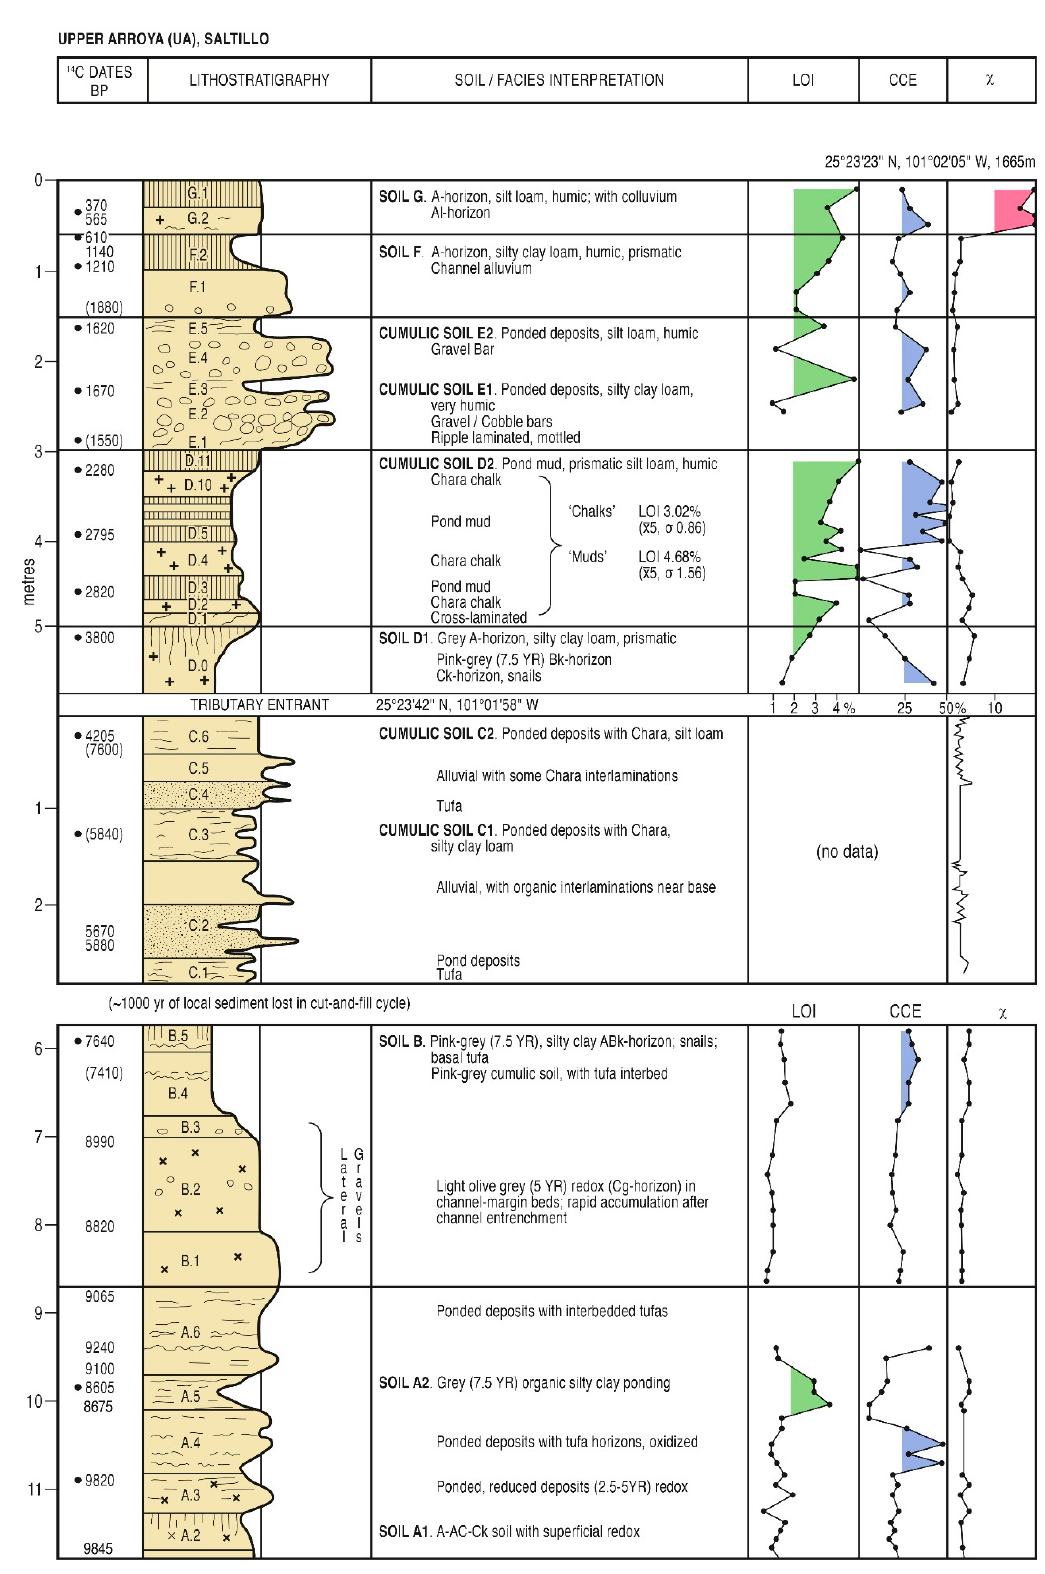
Figure 5. Upper Arroyo (UA) sedimentology with loss-on-ignition, carbonate, magnetic susceptibility ( χ ) data, and location of radiocarbon and AMS dates. Note the high χ values (red highlight) for the period of Spanish Colonial dam construction, indicating eolian sediments and high CCE values (blue highlight) in calcareous tufa and Chara algal layers in the main UA sequence (modified from